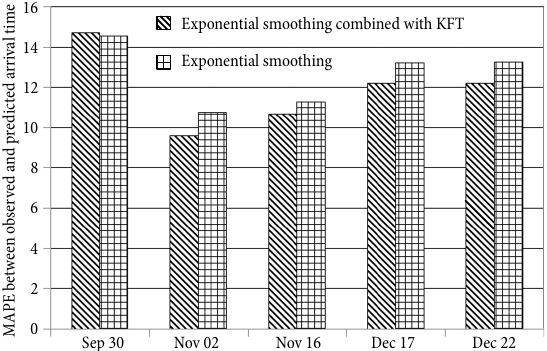
Fig. 3. MAPE between observed and predicted arrival time averaged across bus